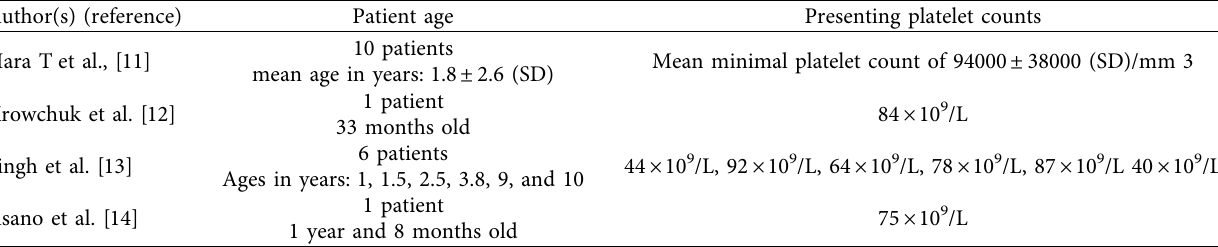
Table 2: Literature review of articles associated with thrombocytopenia and Kawasaki